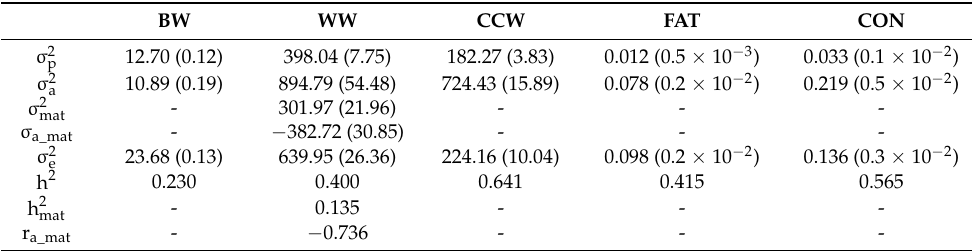
Table 2. Estimates of variance components (standard deviation between brackets), heritabilities and correlations 1 of growth and carcass quality traits 2 .